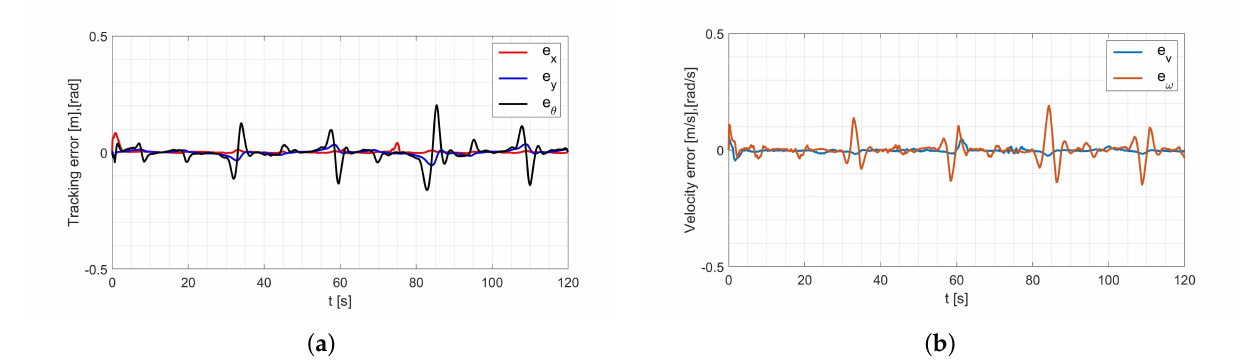
Figure 16. Errors for the Levenberg-Marguardt method: ( a ) tracking the reference trajectory ( b ) velocity.